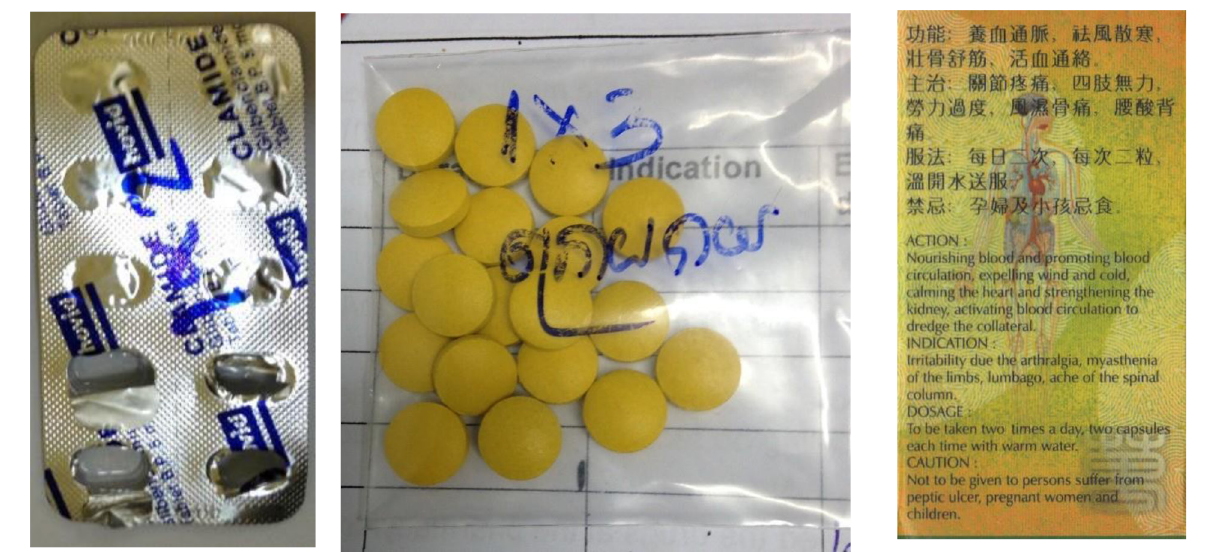
Figure 3. Examples of “written instructions.” Many patients received medication in a plastic bag with simple dosing directions written with a marker on a plastic bag, but usually without the drug name. Occasionally, blister packs were given (name typically in English), with dosing instructions written on the blister pack. Less frequently, a pre-packaged bottle/box was given with instructions typically written in English, French, Thai, or